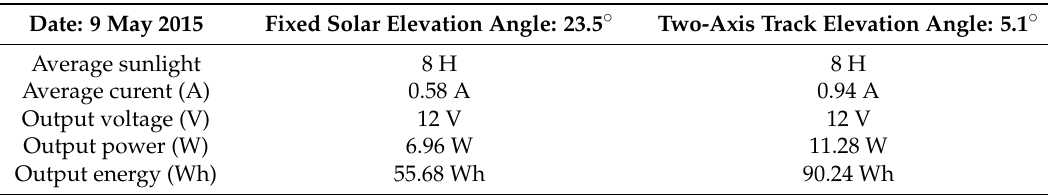
Table 6. Comparison analysis table of output